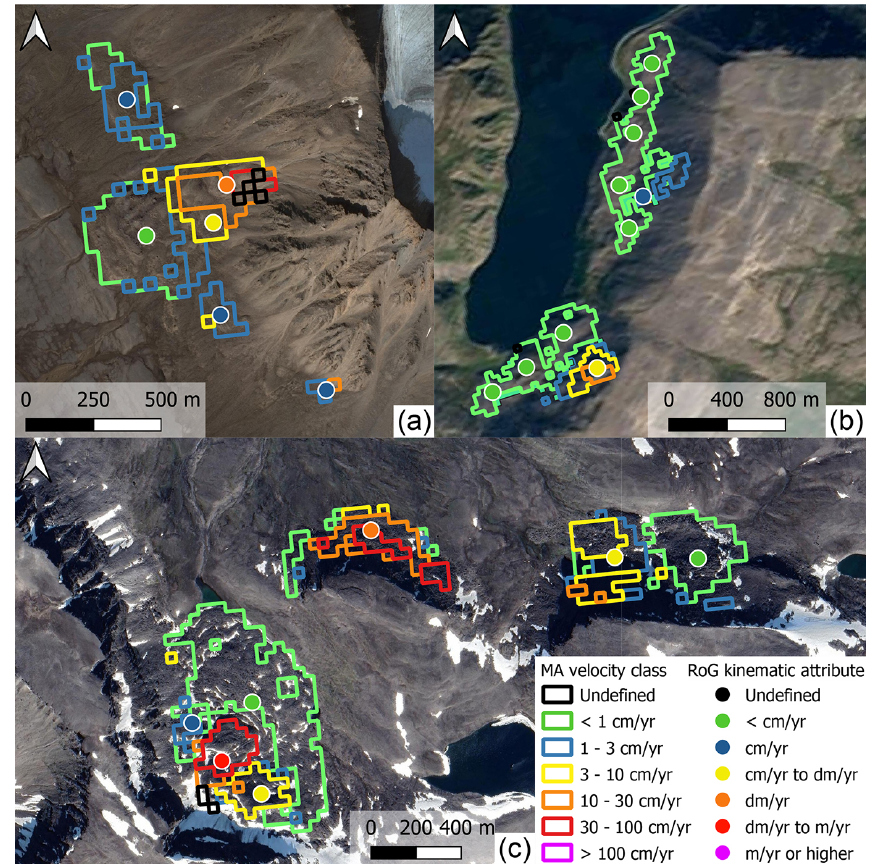
Figure 5. Examples of MAs and RoG kinematic attributes produced for Nordenskiöld Land ( a , location: 77 ◦ 53 (cid:48) 25 (cid:48)(cid:48) N, 13 ◦ 55 (cid:48) 35 (cid:48)(cid:48) E, 300m), Finnmark ( b , location: 70 ◦ 44 (cid:48) 50 (cid:48)(cid:48) N, 28 ◦ 01 (cid:48) 50 (cid:48)(cid:48) E, 100m) and Troms ( c , location: 69 ◦ 26 (cid:48) 45 (cid:48)(cid:48) N, 20 ◦ 42 (cid:48) 40 (cid:48)(cid:48) E, 920m) based on a semi- automated multiple temporal baseline InSAR stacking procedure (Rouyet et al., 2021). Orthoimages from Norwegian Mapping Authority (https://www.norgeibilder.no/; last access: 10 October